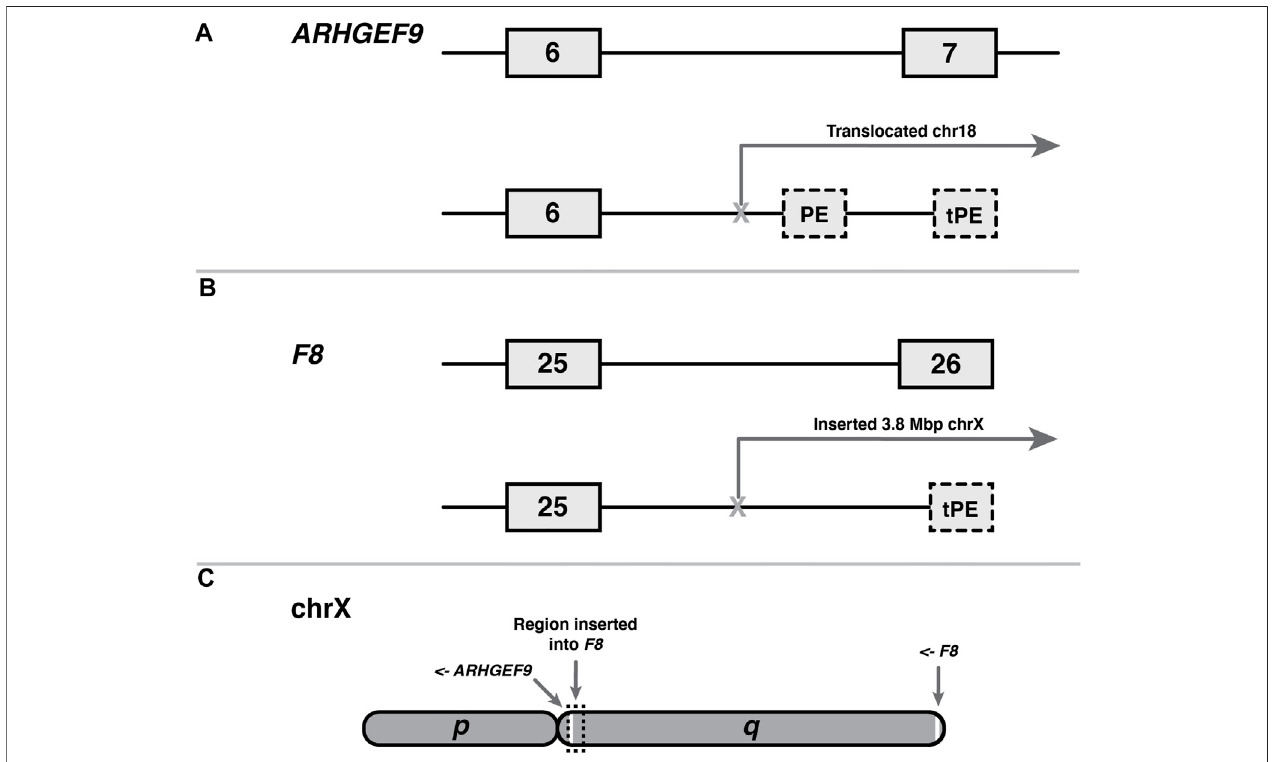
FIGURE 3 | Shared features of two terminal pseudoexons (tPEs). (A) ARHGEF9 tPE ( ARHGEF9 -6-2) and internal PE (ARHGEF9-6-1) arising from within a translocated region of chromosome 18. (B) F8 tPE (F8-25-1) arising within intragenic sequence of a transposed 3.8 Mb tract of the X chromosome. (C) Relative locations, toscale, oftheaffectedgeneson theX chromosomeq-arm, and genomic originoftransposition inpatient B.Arrows indicate reading directionsofeach gene.